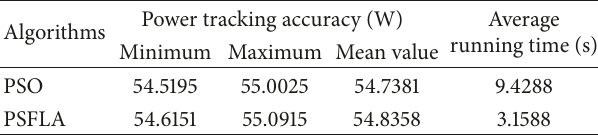
Table 3: Experimental summary results for test 1. Algorithms